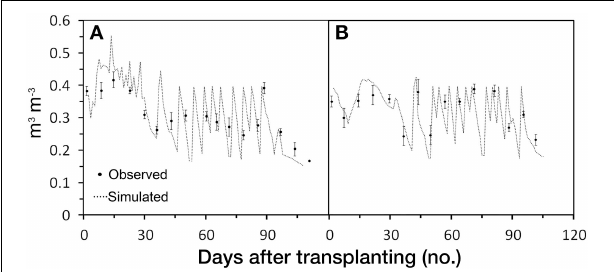
FIGURE 8 | Simulated and observed volumetric soil water content during growing season in FG2005b (A) and FG2006b (B) trials. Standard deviations, when larger than the symbol, are represented by vertical